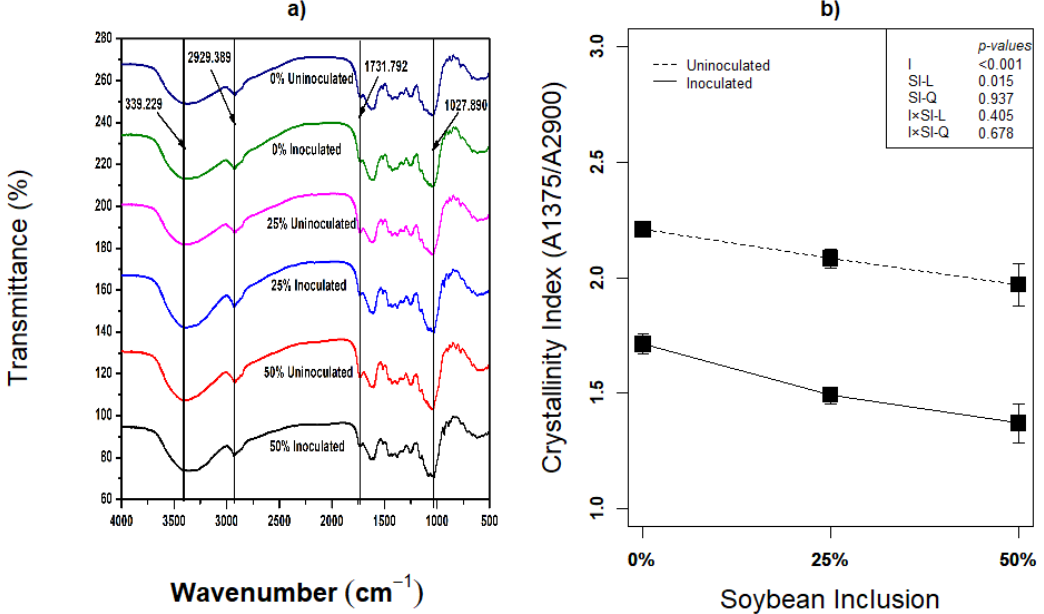
Figure 3. ( a , b ): Influence of soybean inclusion and L. plantarum A1 inoculation on FITR and crys- tallinity index of sorghum silage.